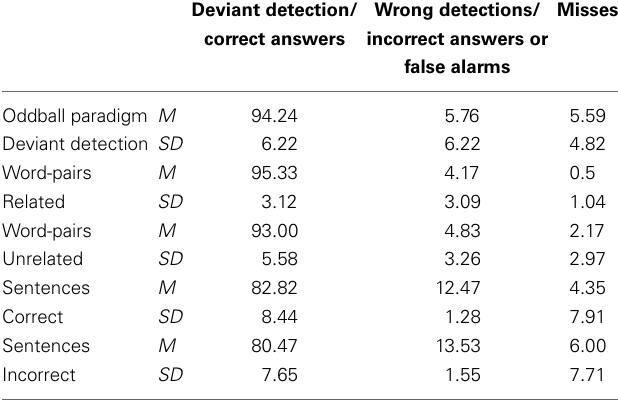
Table 2 | Amount of correct and incorrect answers and misses for the focused attention task for all paradigms, all values are listed in percent